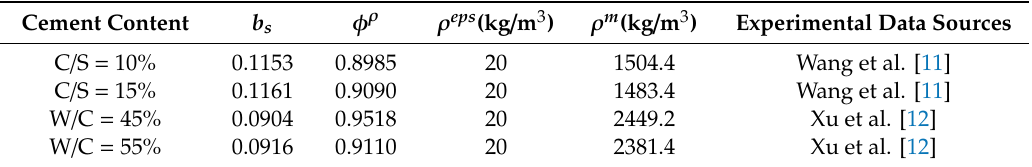
Table 1. Components of lightweight clay.